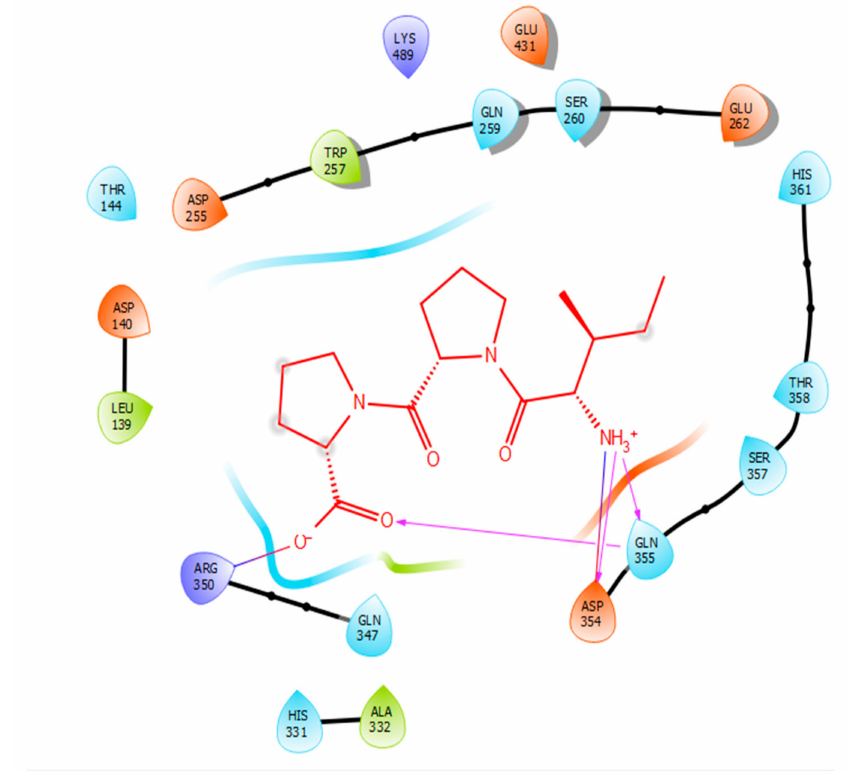
Figure 2. Docking results of the peptide IPP in the active site of human angiotensin I-converting enzyme (ACE). IPP is represented in red, interactions of human ACE residues with the peptide are indicated by arrows of di ff erent colours, with purple representing hydrogen bond interactions and blue arrows representing salt bridge interactions. The figure was generated using the software